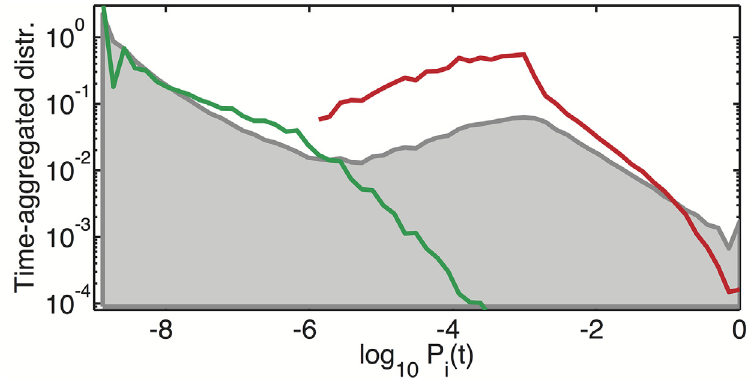
Fig 3. Time-aggregated population size distribution. The grey shaded area shows the time-aggregated distribution of population sizes in our model with γ = 10 − 9 and N = 1000 collected over 20 million collapses. The green and red lines show the population size distributions collected, respectively, at the very end of each wave and at the very beginning of the next wave as described in the text. Note that they roughly correspond to two peaks of the time-aggregated